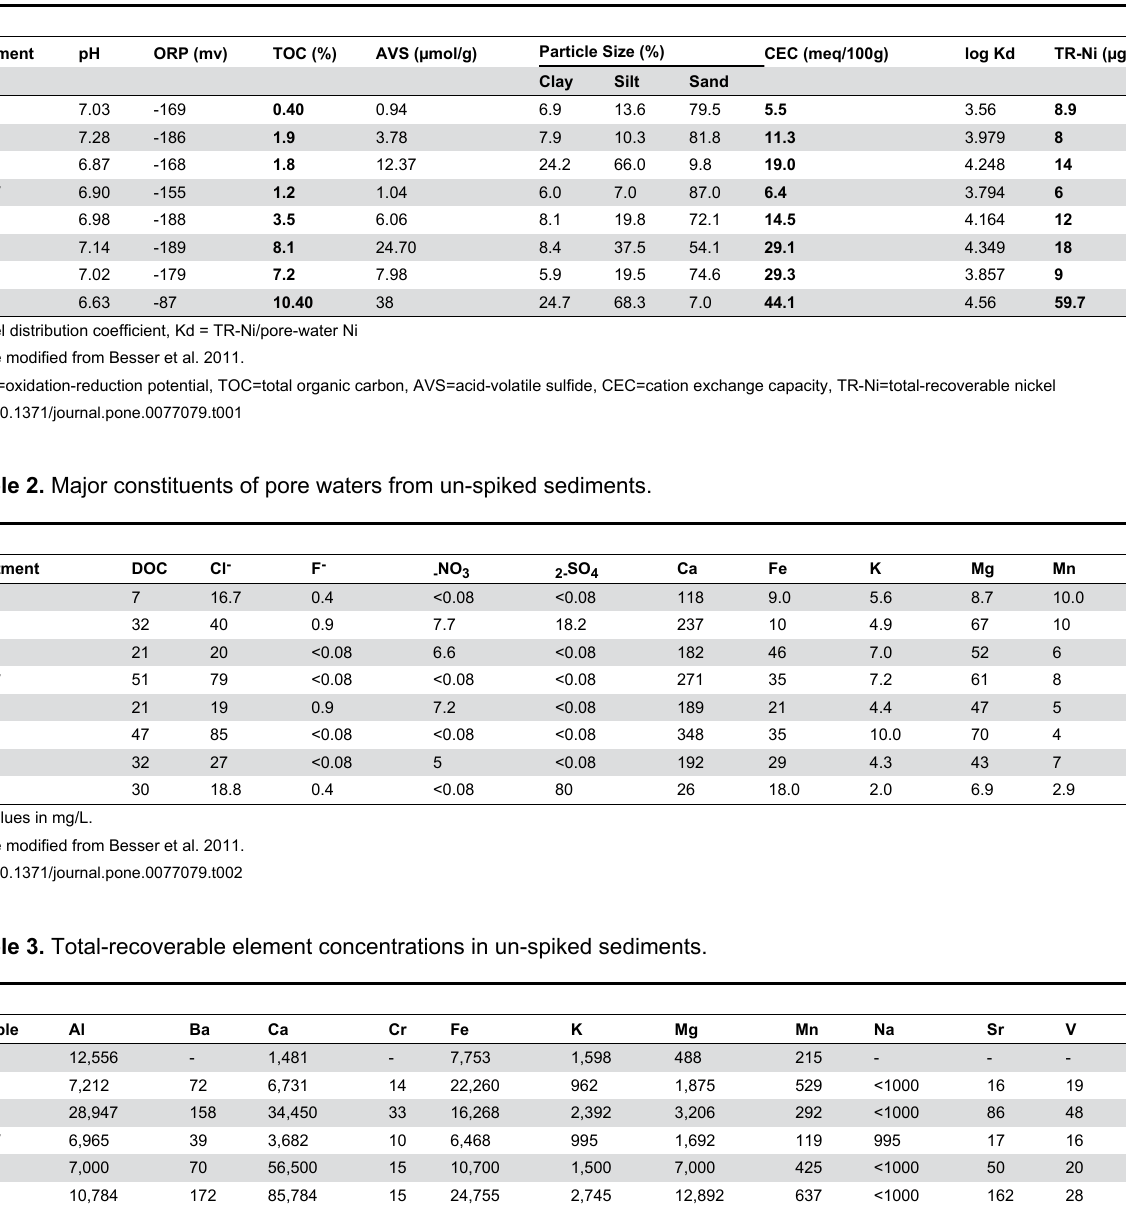
Table 1. Physico-chemical characteristics of un-spiked sediments.